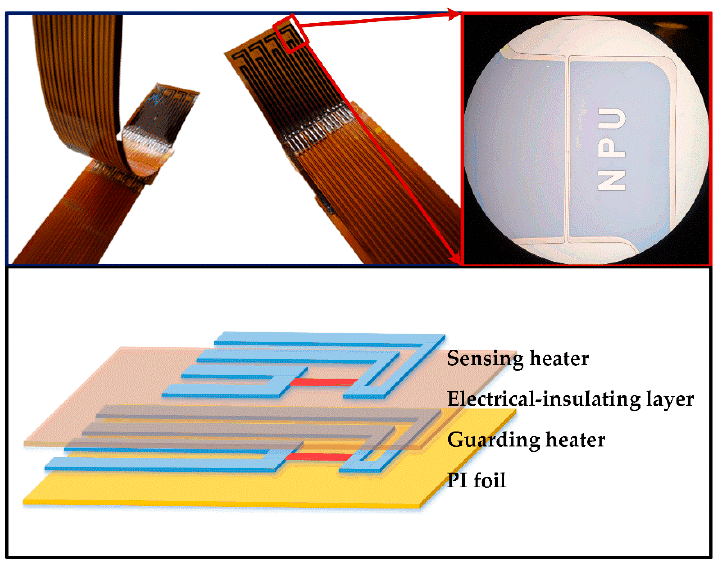
Figure 2. The photograph and structure of the flexible dual-layer hot film sensors.